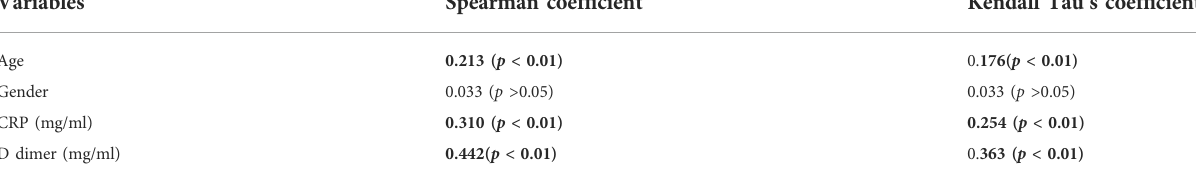
TABLE 1 Correlations between Age, Gender, D-dimer value, CRP value, with Mortality for the combined dataset of ICU and non-ICU COVID-19 patients. Variables